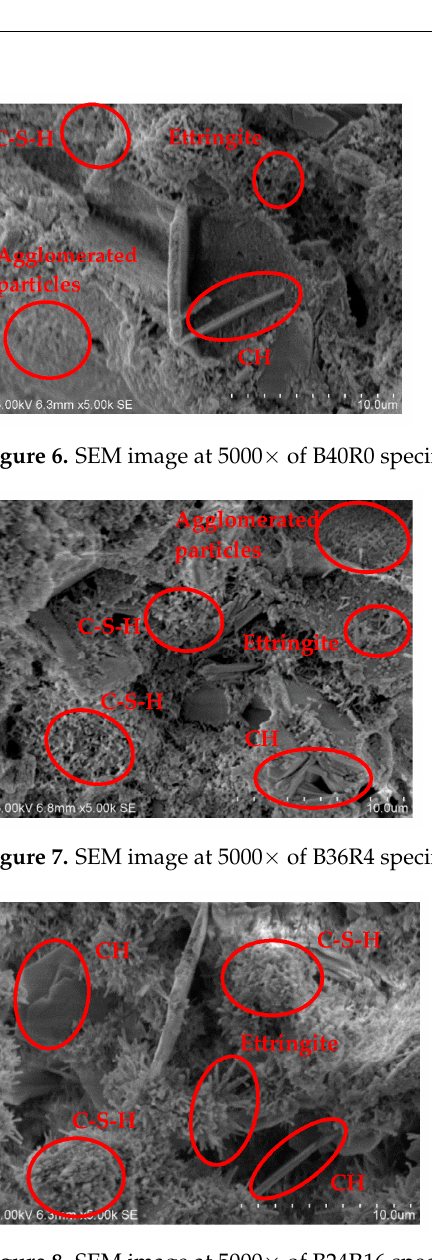
10 of 14 Figure 5. SEM image at 50× and binary image of B40R0, B36R4, and B24R16 specimens. Table 7. Porosity of B40R0, B36R4, and B24R16 specimens. Serial ID